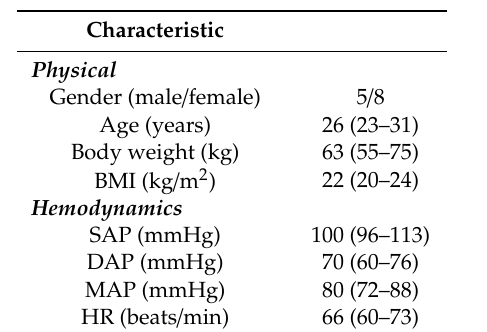
Table 1. Physical and hemodynamic characteristics of the study